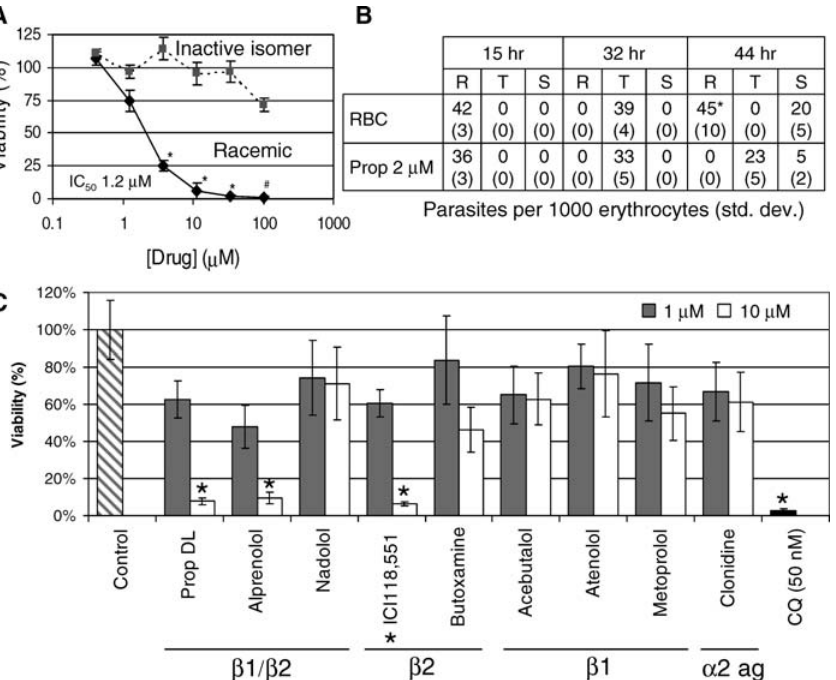
Figure 5. b -Blockers Inhibit Maturation of P. falciparum in In Vitro Cultures ( A) [ 3 H]-hypoxanthine incorporation of P. falciparum 3D7 when treated with racemic propranolol (indicated by black diamonds) or its inactive isomer (indicated by grey squares). Error bars show the standard deviation of triplicate measurements. IC 50 values were determined by fitting the data as described in Methods; the IC 50 value obtained for racemic propranolol (1.2 l M; 95% CI 1.0–1.6 l M) is shown. Three experiments; hatched sign indicates p , 0.001; asterisks indicate p , 0.03 compared to equimolar inactive propranolol. (B) Effect of 2 l M propranolol on intracellular growth in normal erythrocytes. Mock- and drug-treated cultures were monitored at 15, 32, and 44 h after invasion by examination of Giemsa-stained thin blood smears. The number of ring (R)–, trophozoite (T)–, and schizont (S)–stage parasites per 1,000 total erythrocytes at each time point are shown; numbers in parentheses indicate the standard deviation of triplicate measurements from one experiment; the total number of experiments was three. (C) [ 3 H]-hypoxanthine incorporation of P. falciparum 3D7–infected erythrocytes treated with 1 or 10 l M concentrations of adrenergic-acting drugs (nonspecific b 1 / b 2 –antagonists: propranolol, alprenolol, and nadolol; b 2 -specific antagonists: ICI118,551 and butoxamine; b 1 -specific